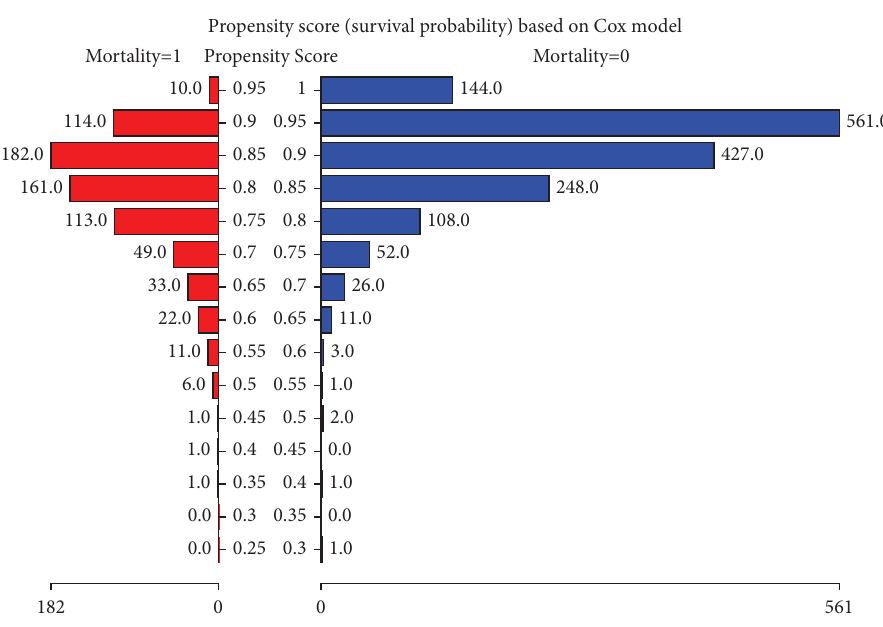
Figure 3: Te PSM of two groups under propensity score based on Cox